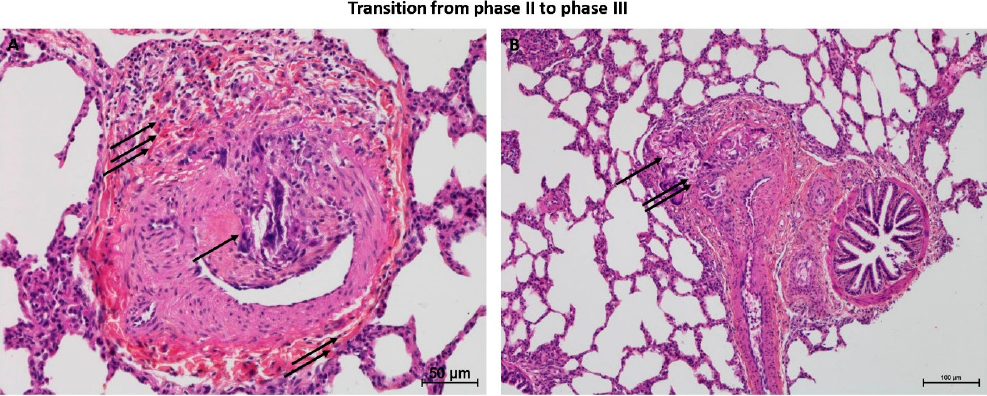
Figure 4. Histopathology of transition between phase II and phase III pulmonary angiophagy in the large animal model of CTEPH (axial cut). ( A ) The embolic specimen (simple arrow) is engulfed into the pulmonary artery wall and covered by endothelial and smooth muscle cells. The double arrow shows a structured collagen layer on the opposite side of the angiophagy process. The triple arrows show a destructured collagen layer on the side of the angiophagy. ( B ) The embolic specimen (single arrow) is situated on both sides of the collagen layer, which shows discontinuity (double arrow). Stain is hematein–eosin–sa ff